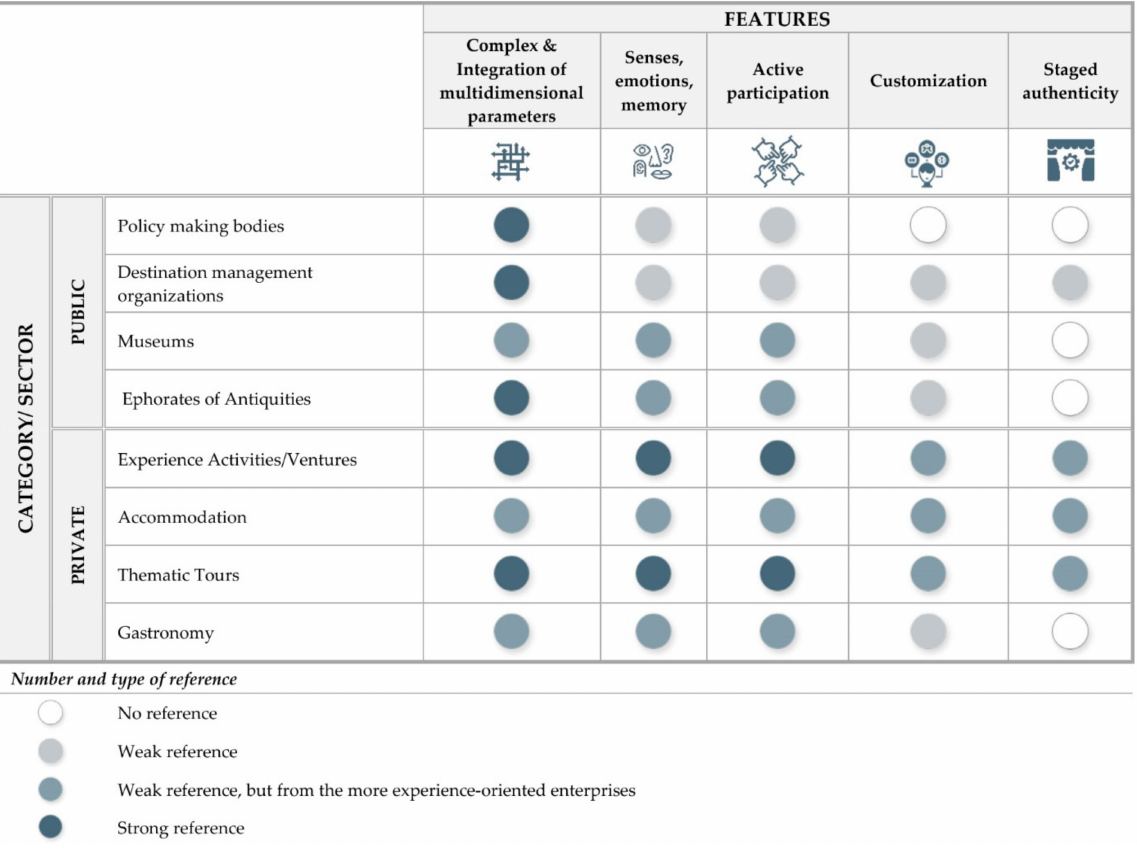
Figure 3. Features of the experiential tourism product, as drawn from the 26 interviews with